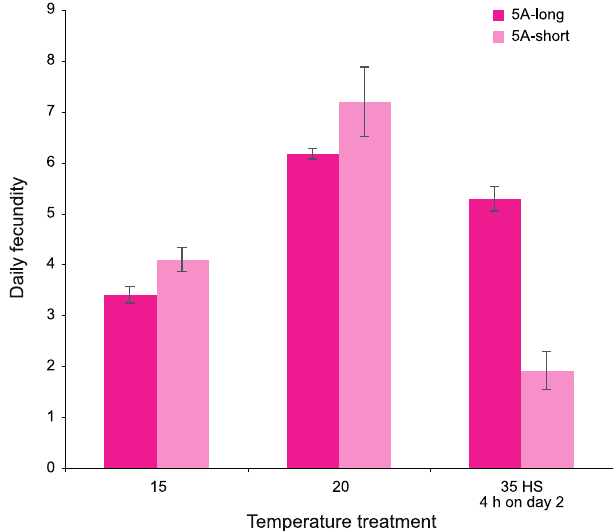
Figure 5. Reproductive Rates under Different Temperature Conditions of Aphid Lines with Buchnera with Different ibpA Promoter Alleles Number of nymphs per day for the first 6 d of reproduction for 5A females with Buchnera bearing the long and short alleles (5A (cid:2) R LONG and 5A SHORT ). Bars show means 6 standard errors. Temperature conditions were constant 15 8 C, constant 20 8 C, and 20 8 C with 4 h at 35 8 C on day 2 following birth.